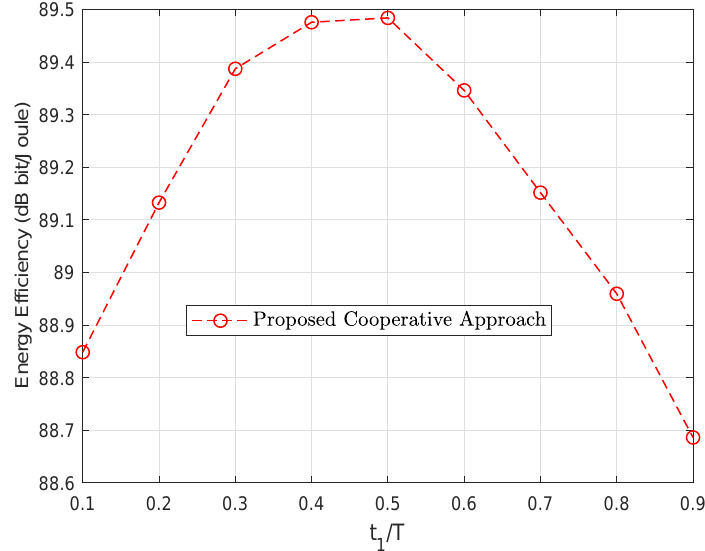
Figure 8. Energy efficiency versus time slot division in the relay transmission link. The parameters M and K are random variables uniformly distributed from 1 to